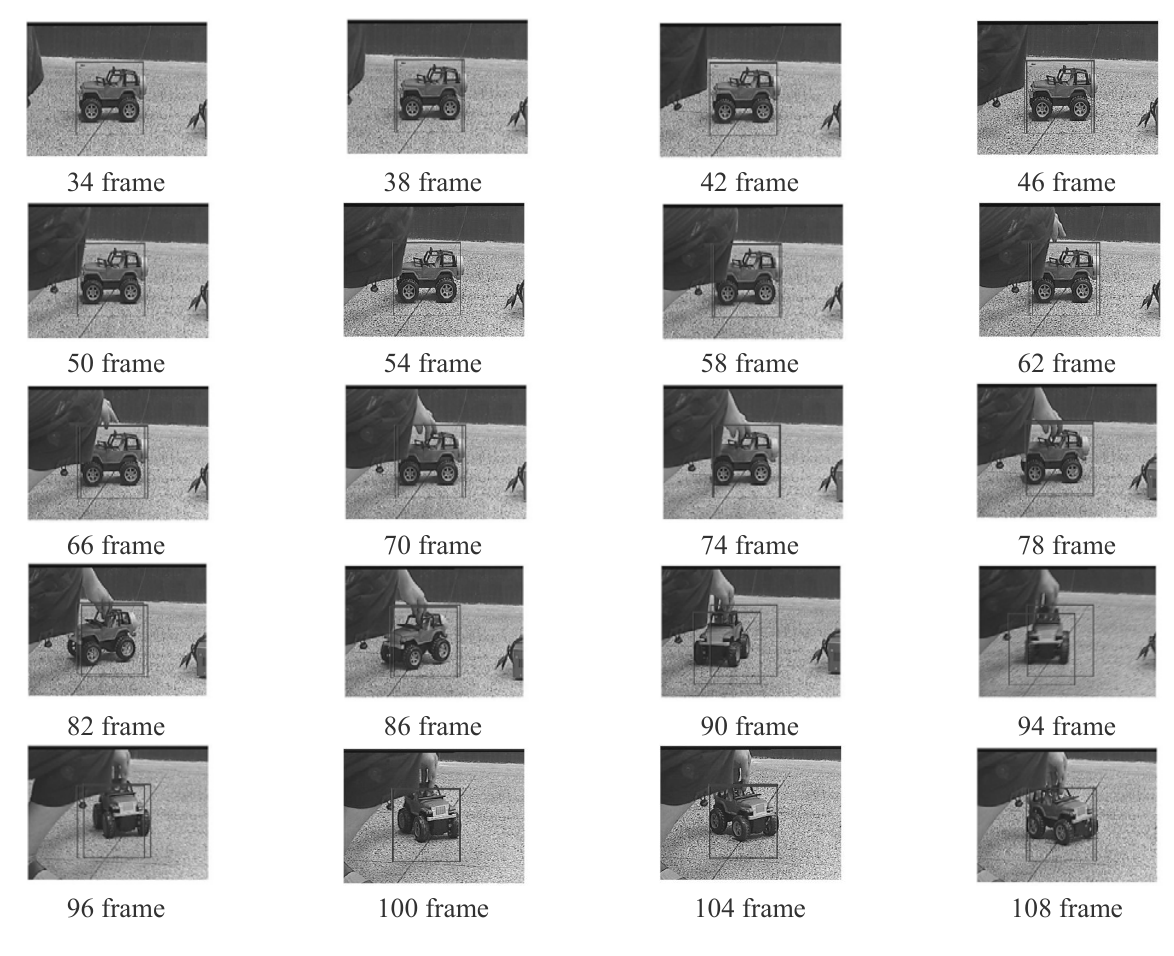
Figure 13. Tracking with proposed method in case of poses variation under complex